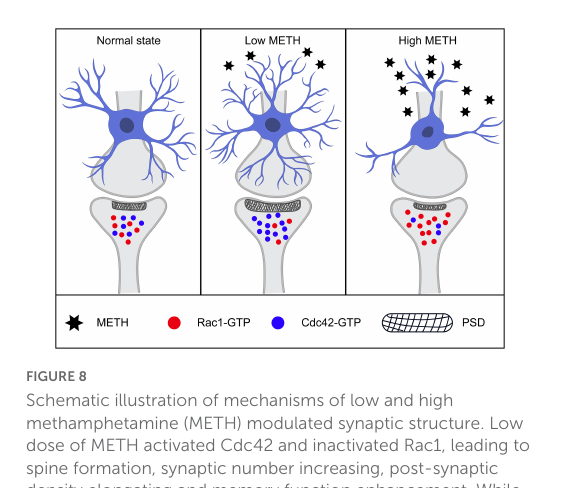
FIGURE8 Schematic illustration of mechanisms of low and high methamphetamine (METH) modulated synaptic structure. Low dose of METH activated Cdc42 and inactivated Rac1, leading to spine formation, synaptic number increasing, post-synaptic density elongating and memory function enhancement. While high dose of METH induced Rac1-GTP increasing and Cdc42-GTP reducing, leading to synaptic